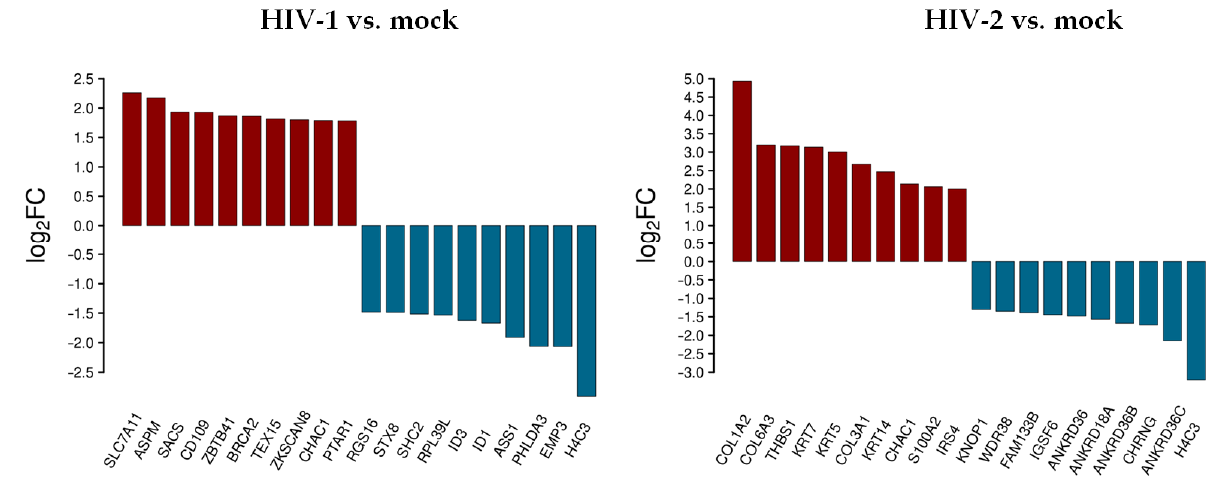
Figure 2. Top 10 selected up- and downregulated protein coding genes 2 h after transduction. log 2 FC of the up- and downregulated transcripts coding for proteins in HIV-1 and HIV-2 transduced HEK-293T cells, respectively, compared to mock transduction.